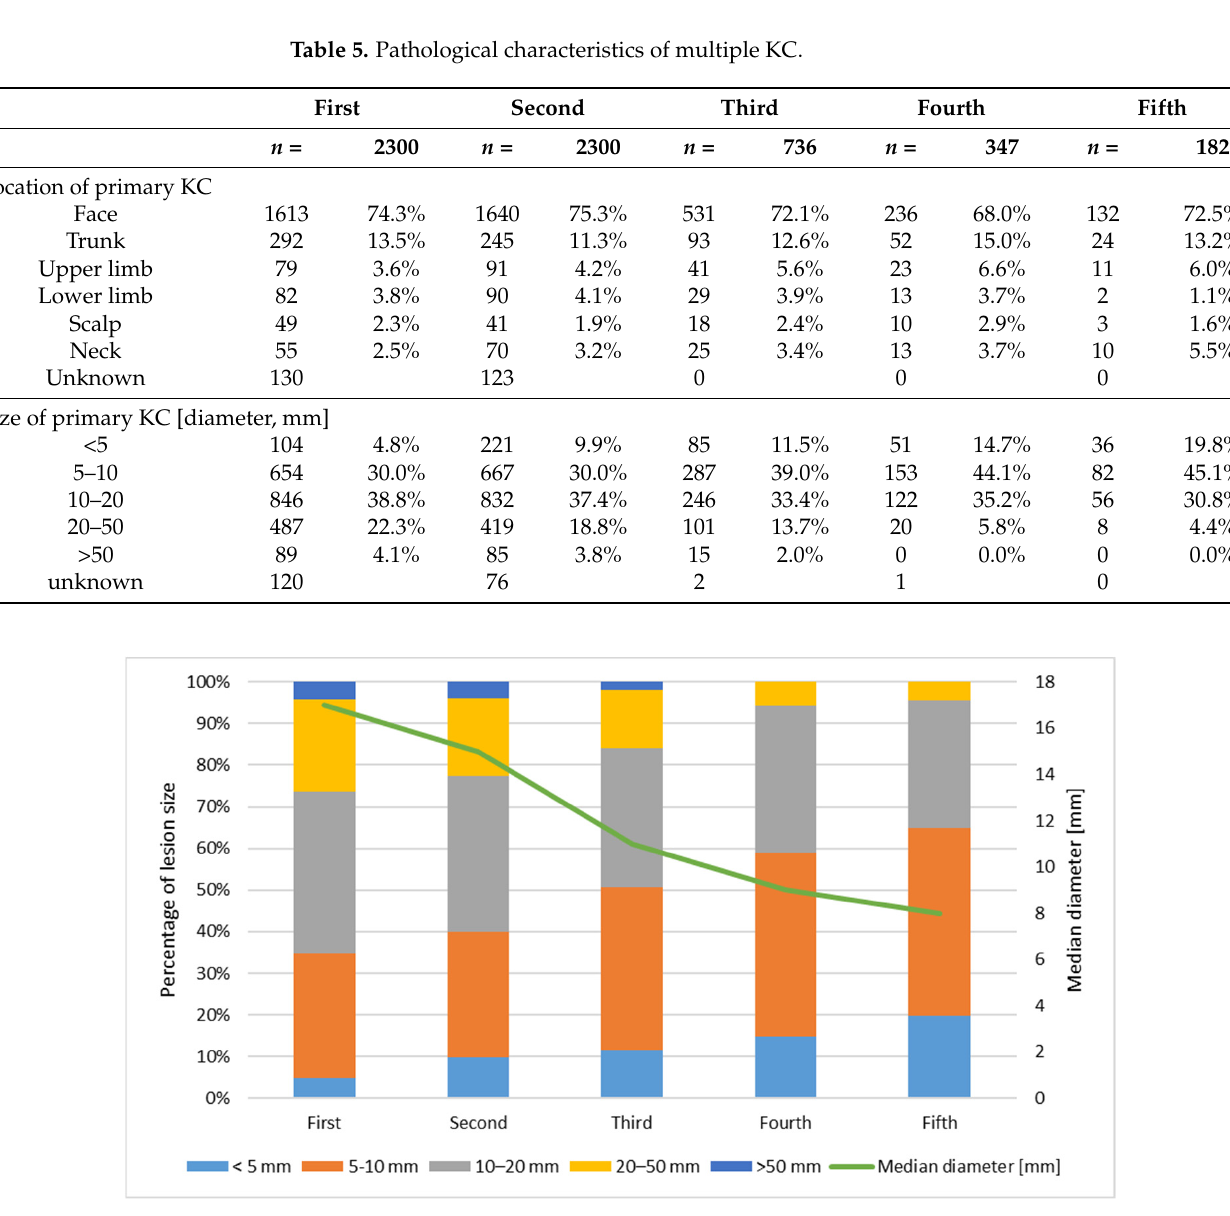
Figure 2. Timing between subsequent primary KC development. 4. Discussion Patients with skin cancer are at a higher risk of other KC development [17,18]. Cur- rently, most studies focus on the analysis of subsequent BCC and SCC cases without an investigation of the specific BCC subtypes [13]. In this study, the risk of developing a sub- sequent SCC and BCC in patients with former skin cancer was analyzed taking into con- sideration the certain subtype of BCC to provide a comprehensive view on the current data. Multiple primary KCs were recognized in 22.8% of a constructed cohort of patients from our databases, which is consistent with various studies, and the incidence ranged between 20% and 67% [19–28]. However, the risk of a subsequent KC developing differs depending on the primary subtype. Patients diagnosed with infiltrative or basosquamous BCC are about two times more likely to grow another KC than patients diagnosed with less aggressive BCC subtypes, such as nodular and superficial. The higher risk for subse- quent skin cancer development was not observed for patients with primary SCC and were similar to patients with nodular and superficial BCC. These discoveries are outstanding as it may be anticipated that patients developing primary SCC could tend to an increase in probability of further KCs, as SCC is defined as a more aggressive KC type.